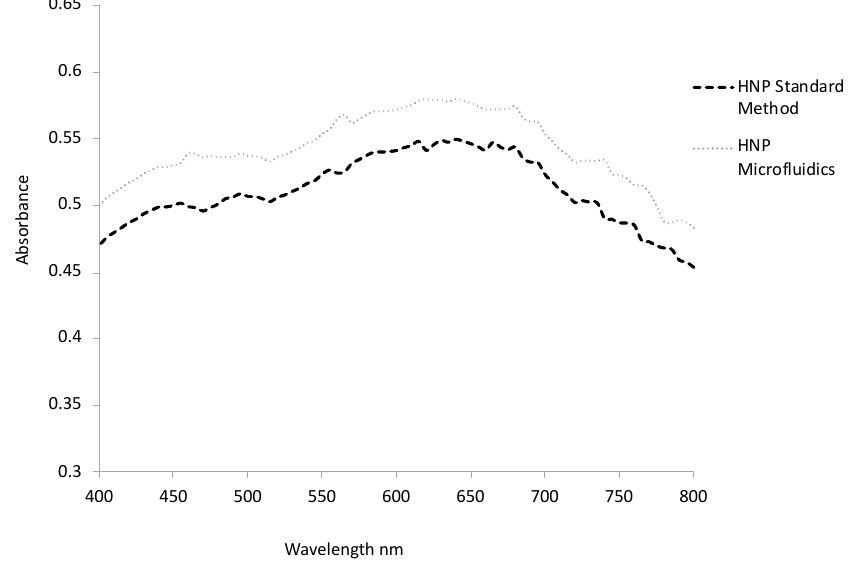
Figure 4. UV-vis spectroscopy of HNPs produced by standard methods and microfluidics. Samples scanned in deionised water over 400–800 nm.